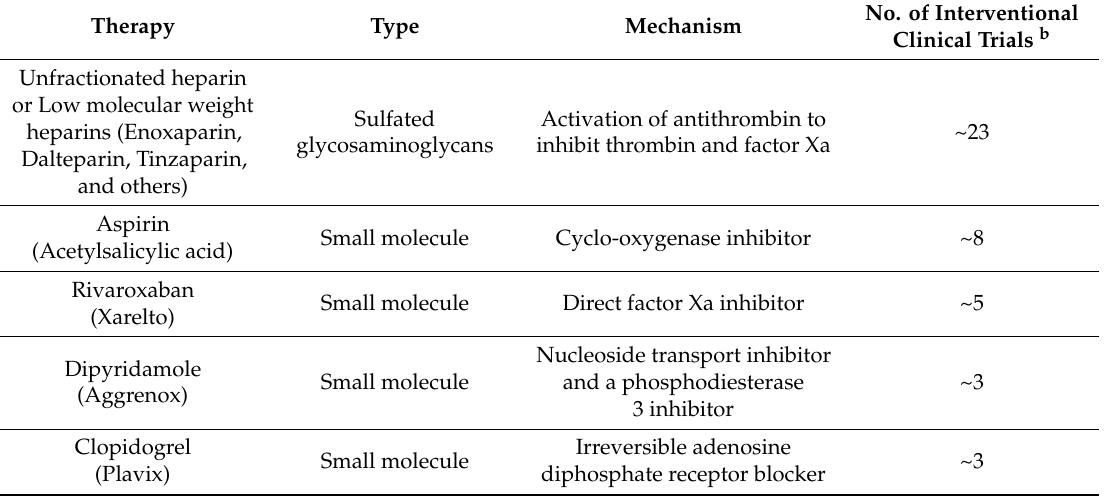
Table 3. Most frequently evaluated antithrombotics in clinical trials for COVID-19 a